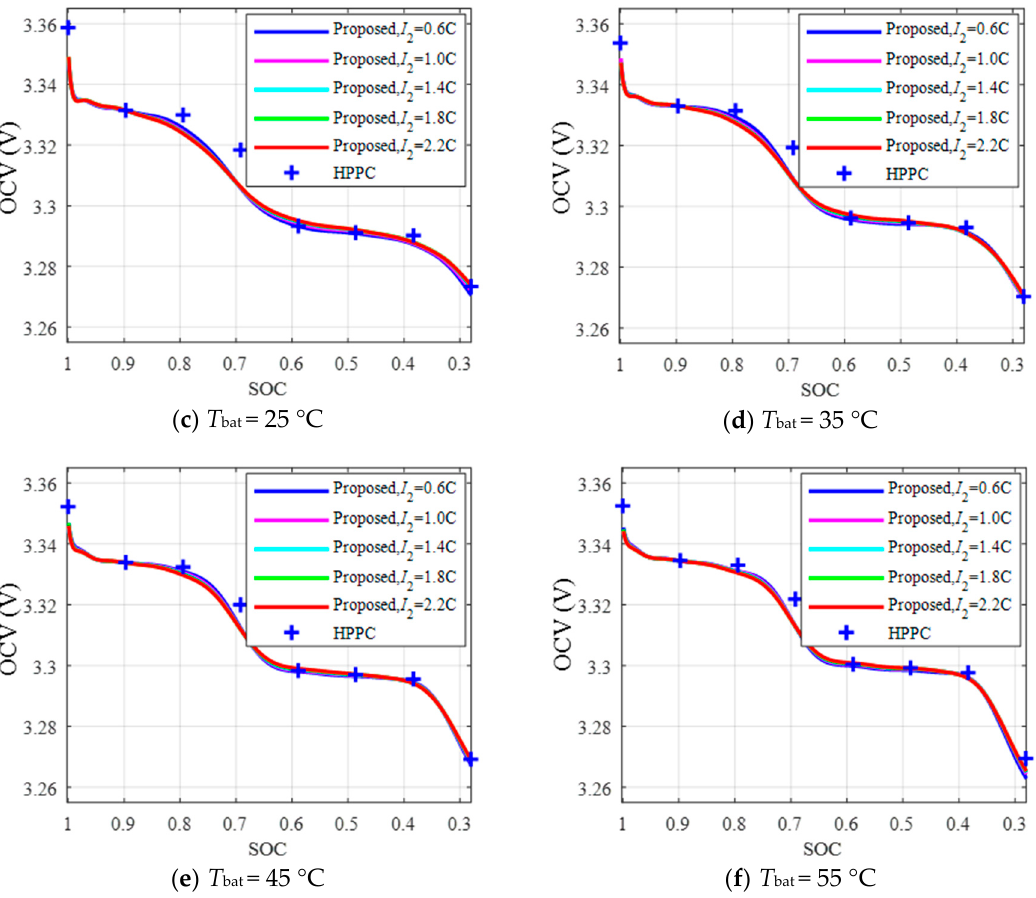
Figure 9. Estimation results of the HPPC method and the proposed method of different I 2 ( I 1 = 0.2 C, where C means the C rate). ( a ) T bat = 5 °C; ( b ) T bat = 15 °C; ( c ) T bat = 25 °C; ( d ) T bat = 35 °C; ( e ) T bat = 45 °C; ( f ) T bat = 55 °C.